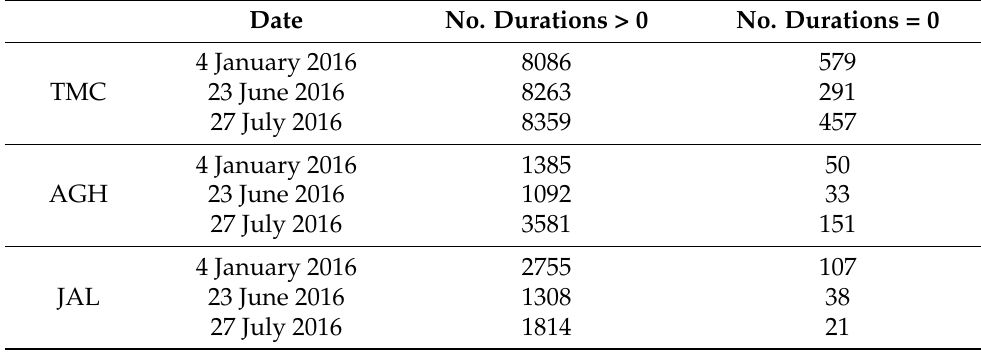
Table 1. Basic information comparison for Toyota Motor Corporation (TMC) (Aichi, Japan), Asahi Group Holdings, Ltd. (AGH) (Tokyo, Japan) and Japan Airlines Co., Ltd. (JAL) (Tokyo,